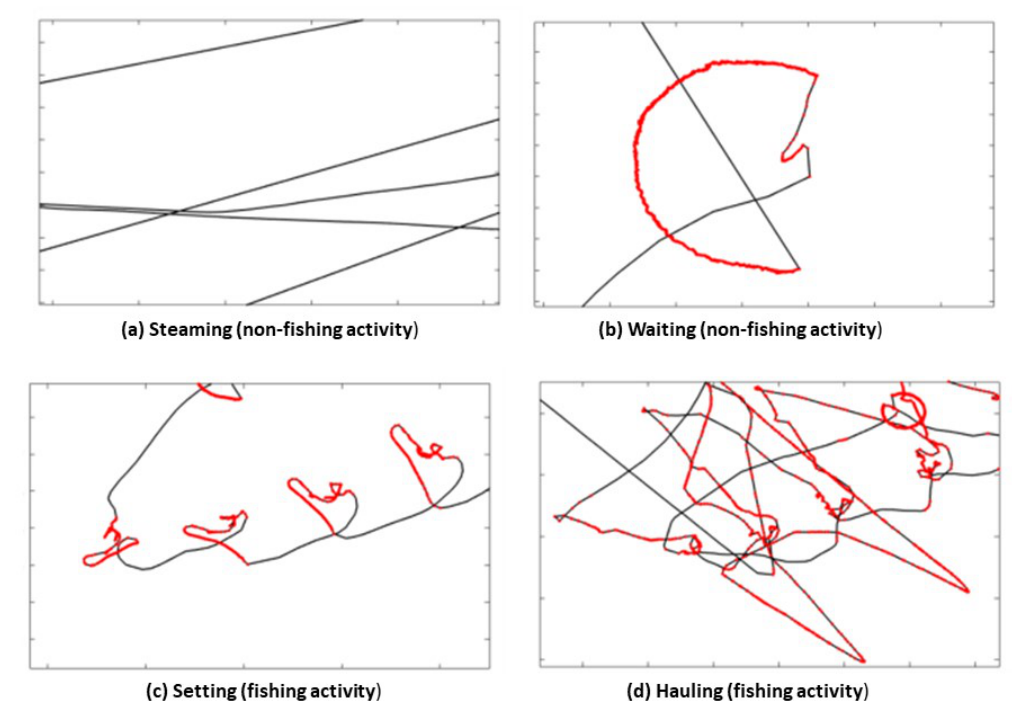
Figure 1. Trajectories of fishing and non-fishing activities. ( a ) Steaming (non-fishing), ( b ) waiting (non-fishing), ( c ) setting (fishing), and ( d ) hauling (fishing): the black tracks indicate a section with a speed of 6 knots or more and red tracks indicate ones with a speed of less than 6